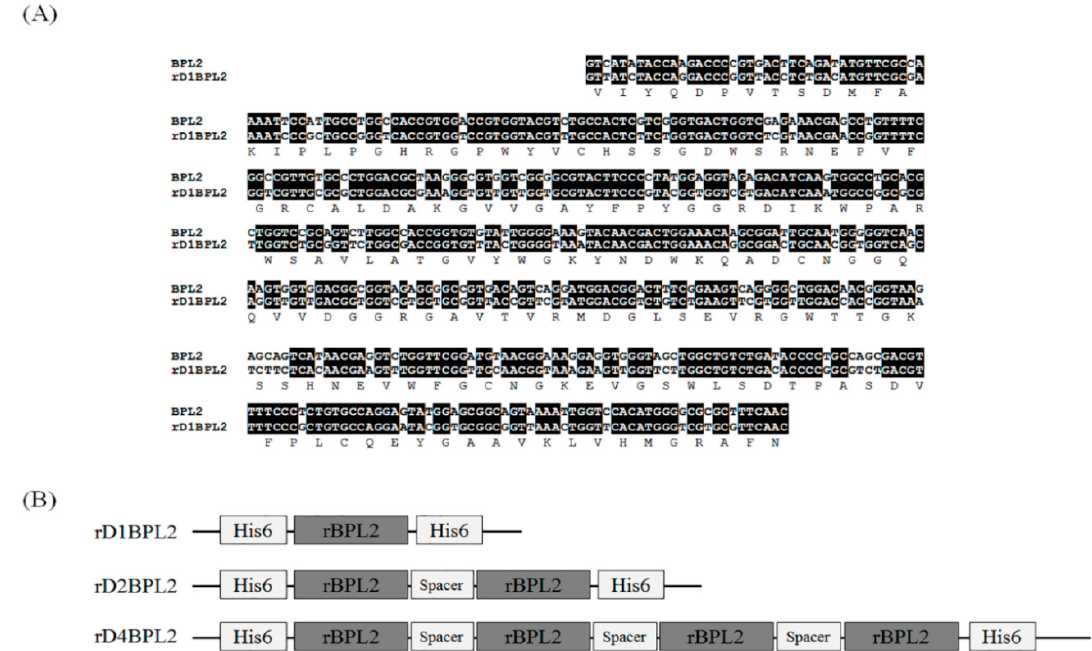
Figure 2. Construction of different forms of recombinant BPL2 by tandem repeats. ( A ) Codon optimization of cDNA and deduced amino acid sequence. ( B ) Illustration of recombinant protein structure, in which have tandem repeats were connected by spacer sequences. All constructs contained a His tag to allow for isolation/purification.